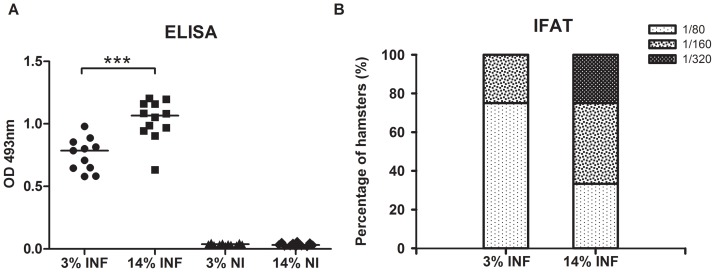
Serum antibodies detected by SLA ELISA (A) and IFAT (B).The difference in response, as measured by ELISA, of the hamsters fed the 3% and 14% protein diets was significantly different. ***p<0.001. Data show medians of one representative experiment of two independent assays.